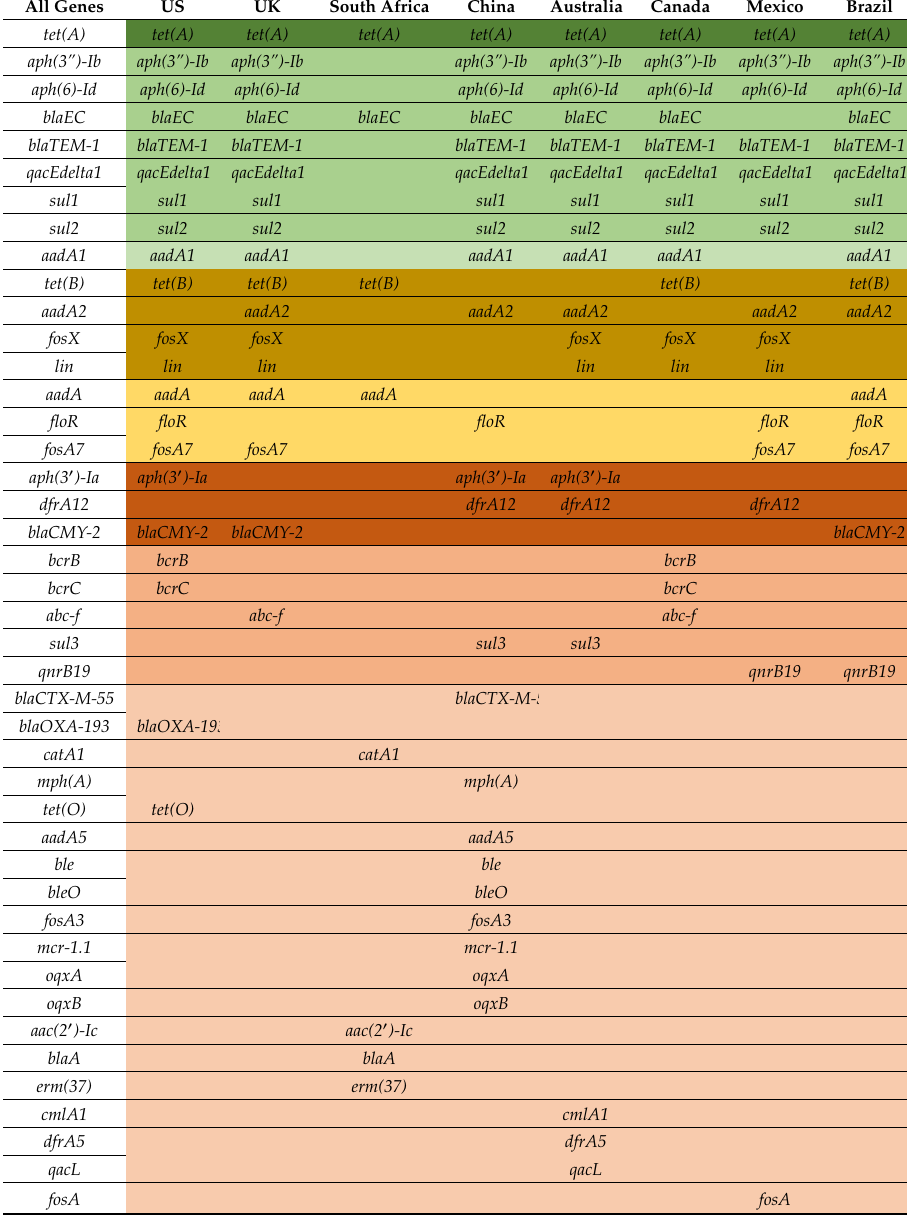
Table 1. Highest occurring AMR genes sorted and color coded by their presence in each country (indicated by PC and hierarchical clustering for countries: the US, the UK, South Africa, China, Australia, Canada, Mexico, and Brazil). The genes are listed from the highest occurring frequency (commonly present in all eight countries) to the lowest frequency (commonly present in only one country). Di ff erent occurring frequencies are marked in di ff erent colors, e.g., dark green for AMR genes commonly present in eight countries, and light green for AMR genes commonly present in seven